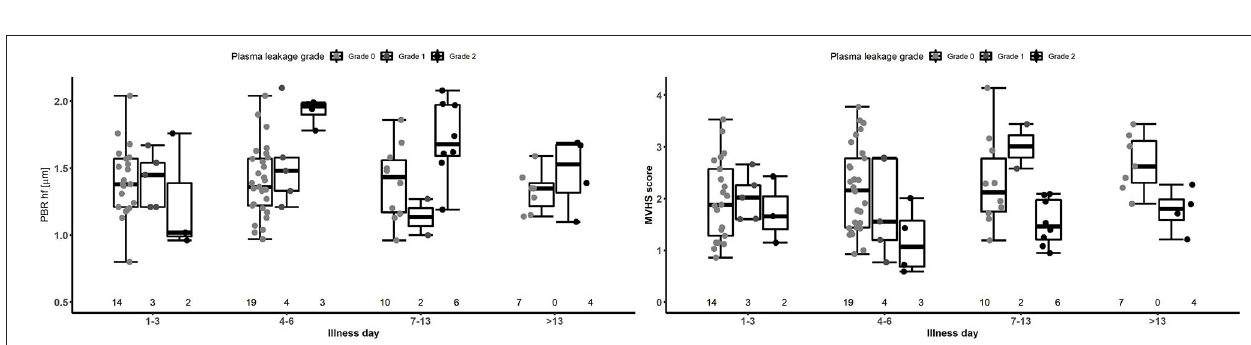
FIGURE 3 | Boxplot of PBR hf and MVHS by plasma leakage grade and disease phase for patients with laboratory confirmed dengue. Dots represent individual values of PBR hf and MVHS in each group. The number represents the number of patients that contributed to each group. The graph is based on 36 patients contributing 87 measurements. PBR hf, Perfused Boundary Region high flow; MVHS, MicroVascular Health